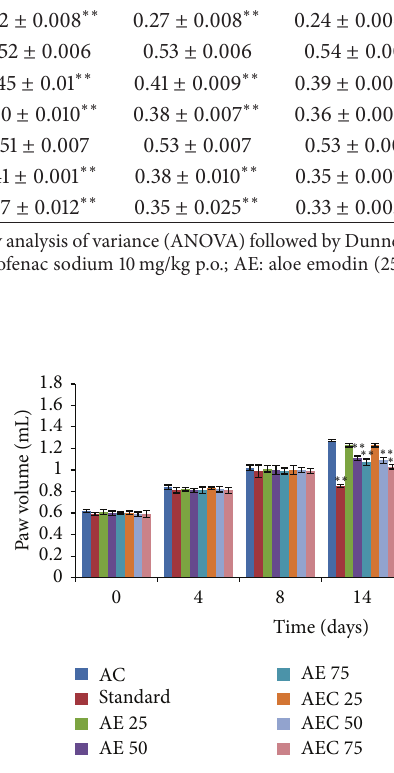
Figure 4: Effect of AE and AEC on injected paw volume in Freund’s complete adjuvant induced arthritic rats. Results were presented as mean ± SEM ( 𝑛 = 6 ). The data was analysed using one-way analysis of variance (ANOVA) followed by Dunnett test. ∗ 𝑃 < 0.05 , ∗∗ 𝑃 < 0.01 when compared with arthritic control group. AC: arthritic control; Std.: Diclofenac sodium 10mg/kg p.o.; AE: aloe emodin (25, 50, and 75 mg/kg p.o.); AEC: carboxylic acid derivative of aloe emodin (25, 50, and 75 mg/kg